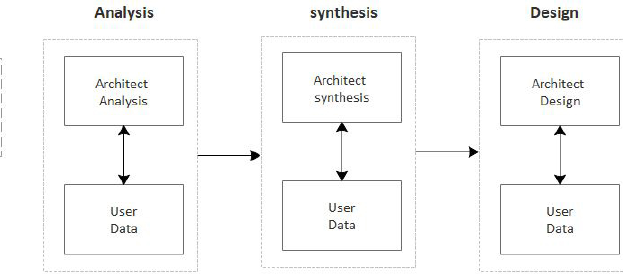
Figure 6. Interactive participation model (source: authors)